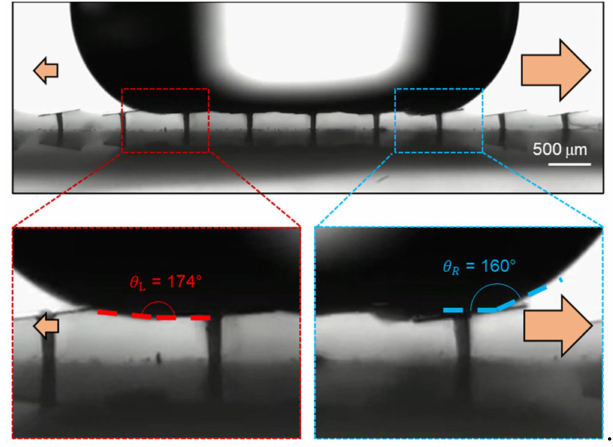
Figure 7. The two different contact angles of a water droplet with a volume of 17.4 µ L on a black silicon ratchet surface.